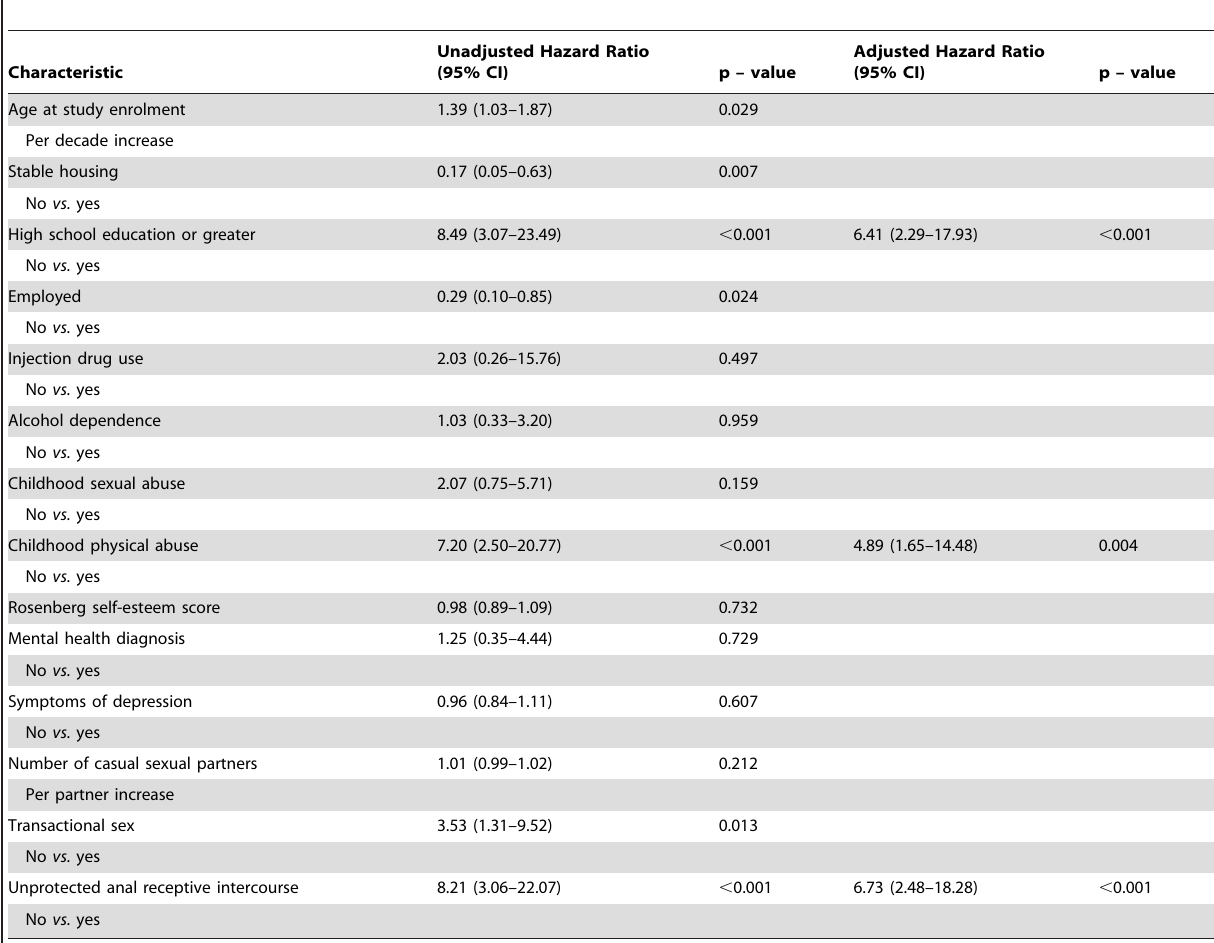
Table 2. Bivariable and multivariable analysis of factors associated with time to HIV seroconversion among young HIV-negative gay and bisexual men in Vancouver, Canada